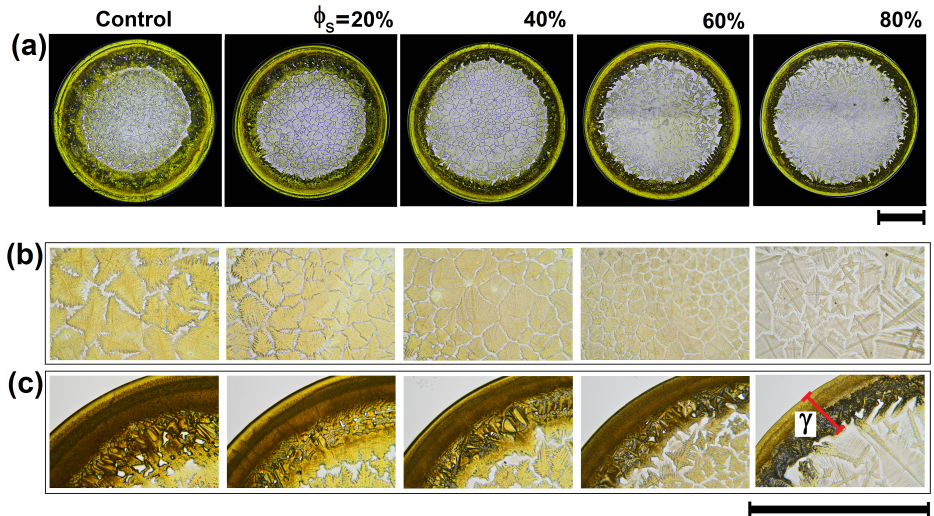
Figure 2. Deposits obtained from diluted Methotrexate with tap water. ( a ) Methotrexate/NaCl deposits produced by mixing drug solutions with varying ratios of tap water. Droplet evaporation was carried out on a solid surface at T s = 63 ◦ C and RH = 25%. ( b ) Zoom at central region of the deposits. ( c ) Zoom at representative crown region of the deposits. The length of the black lines indicate 1mm. The red line shows the crown thickness γ . For each pattern, γ is the average of 8 measurements in different regions in the